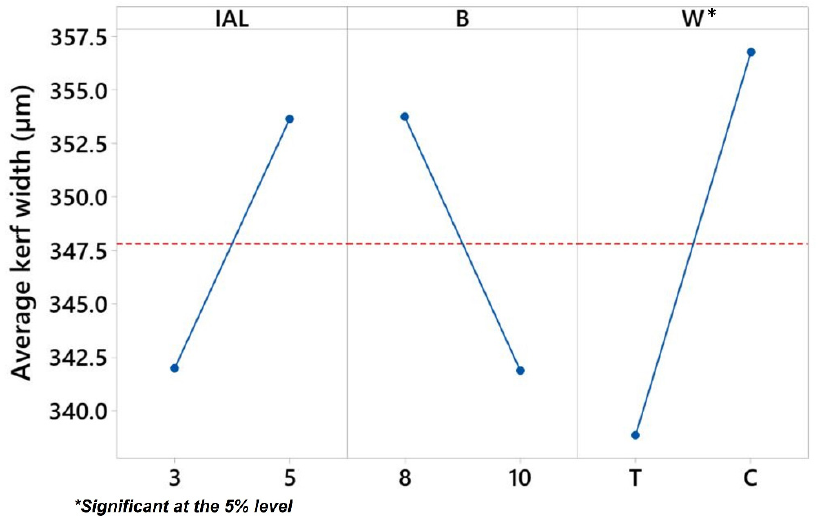
Figure 10. Main effects plot for average kerf width.